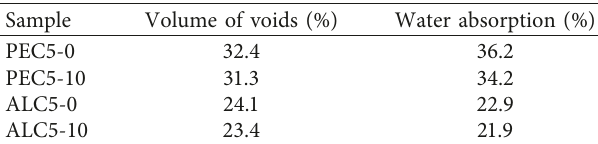
Table 4: Volume of voids and water absorption of concretes manufactured with perlite (PEC) and with aliven (ALC) with and without addition of